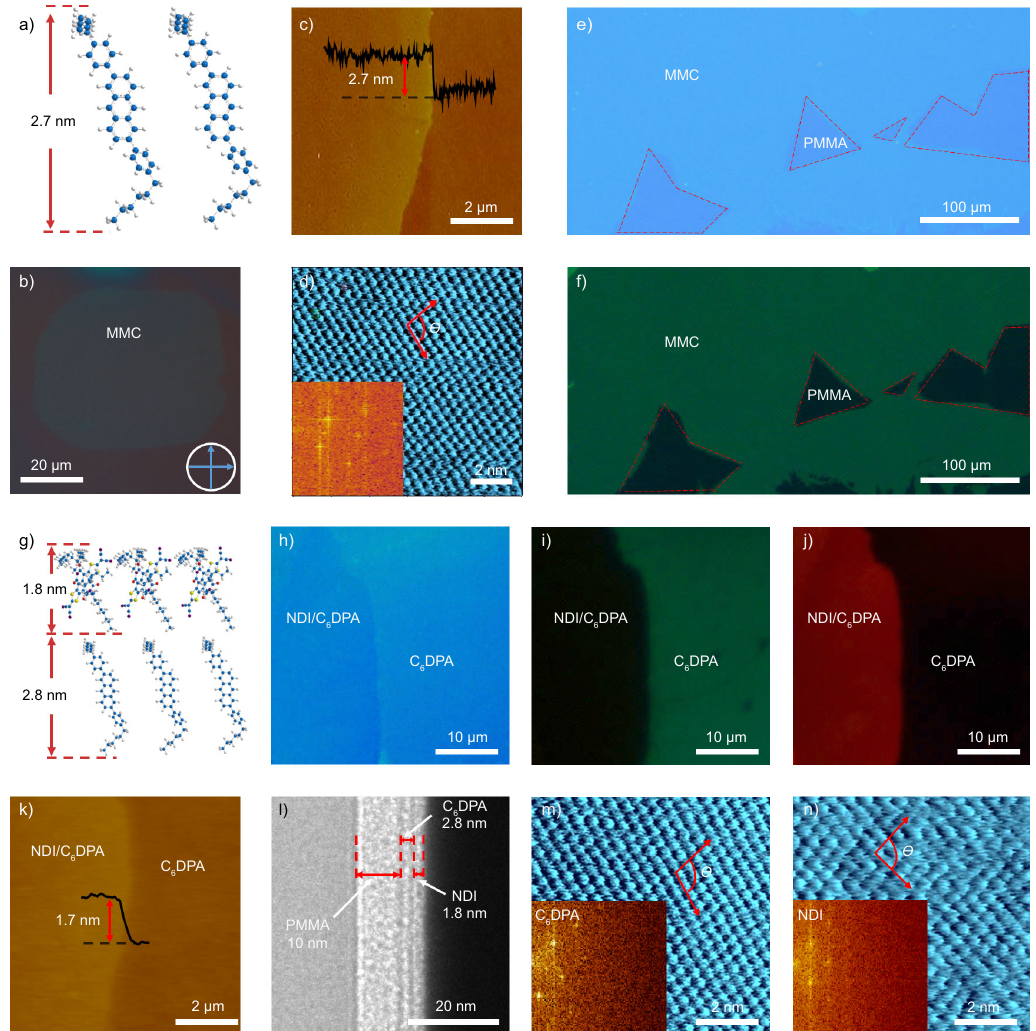
Fig. 1 Characterization of 2,6-bis(4-hexylphenyl)anthracene (C 6 DPA) monolayer molecule crystals (MMCs) and bimolecular layer p – n heterojunctions. a Molecular arrangement of C 6 DPA MMCs with thickness of around 2.7 nm. Blue represents carbon atom and gray represents hydrogen atom. b – f Characterizations of C 6 DPA MMCs: b cross-polarized optical micrograph; c atomic force microscopy (AFM) image; d high-resolution AFM